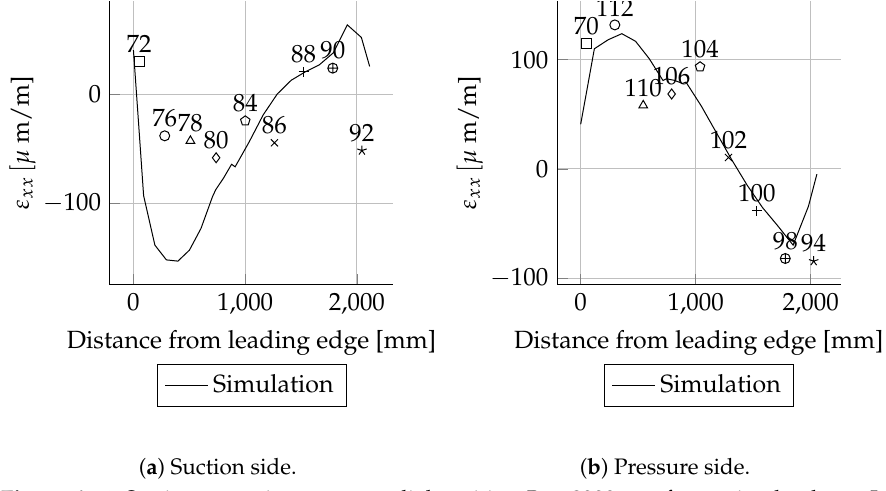
Figure A64. Strain comparison ε LL at radial position R = 8000mm for torsion load case LC_3.